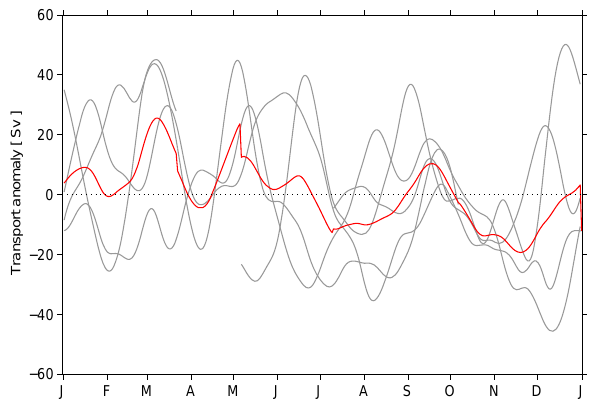
Figure 7. Annual cycle of DWBC volume transport (integrated 800–4800dbar across the entire array); transport anomalies are shown relative to the record-length mean. Gray lines are individual years; red line is the average of all years. Transport time series was low-pass filtered with a 30-day cutoff period to reduce the higher frequency